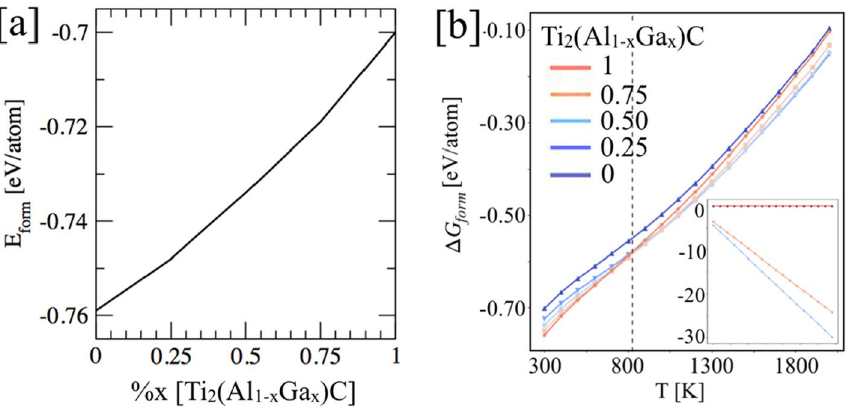
Figure 2. The density-functional theory predicted ( a ) formation enthalpy (0 K), and ( b ) relative phase stability of Ti